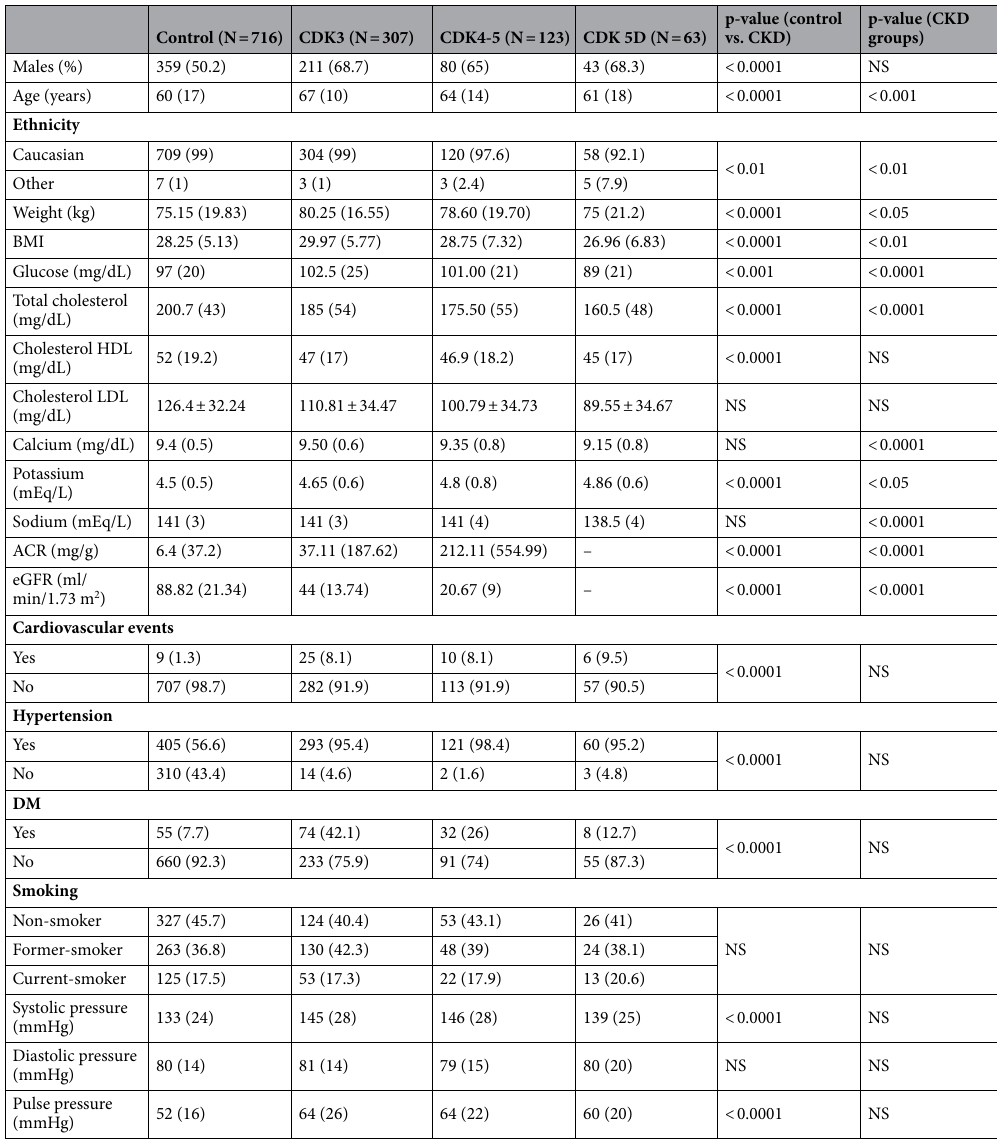
Table 1. Demographic and clinical parameters of the study population. This same population has also been analyzed in previous studies by our group 11,12 . BMI body mass index, eGFR estimated glomerular filtration rate, DM diabetes mellitus, ACR albumin-to-creatinine ratio, NS not